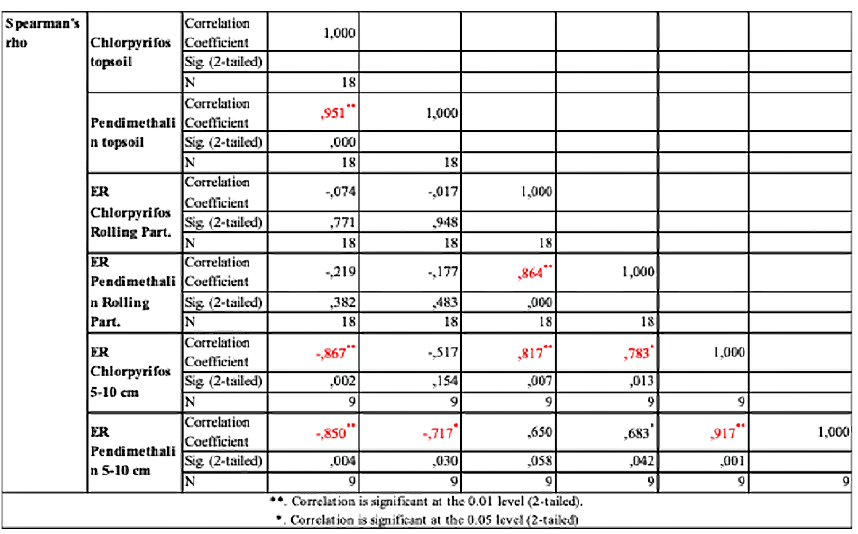
Figure 12. The connection between the Chlorpyrifos concentration in the soil surface before blowing and the ER of Chlorpyrifos Table 2. Values of Spearmen’s correlation